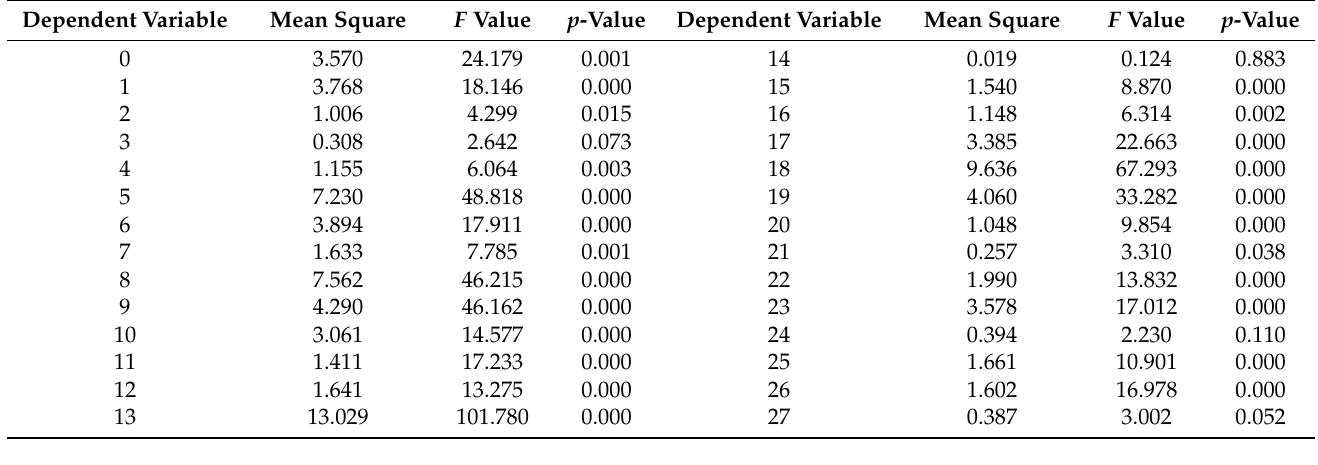
Table 1. The difference analysis of the 28 scenic units.